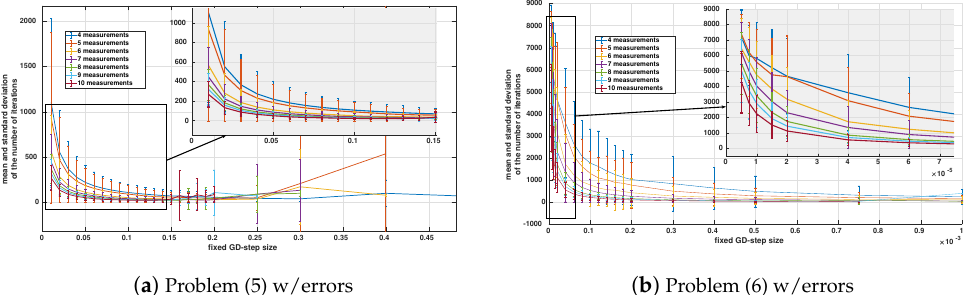
Figure 5. Mean number of iterations to convergence with standard deviation on 10,000 simulations using GD with fixed-step descent for estimation problems (5) ( a ) and (6) ( b ), respectively, including position and range measurement error models and by varying the number of neighboring nodes from 4 to